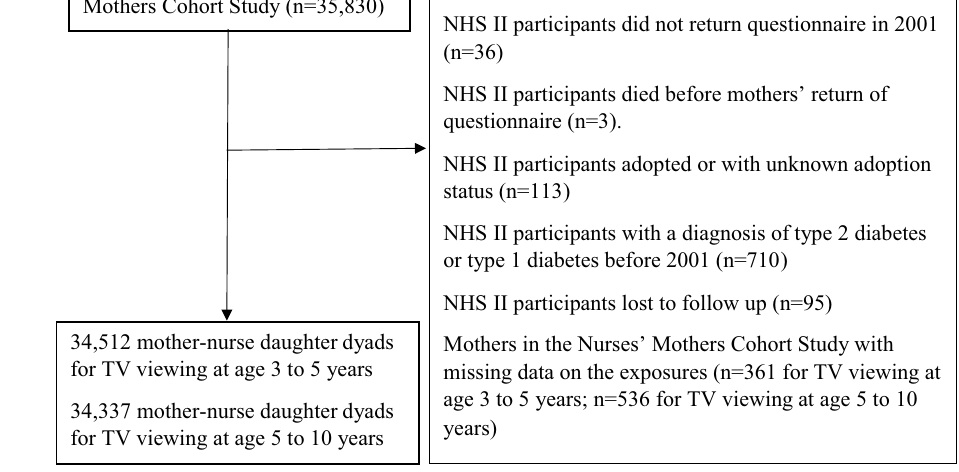
Figure 1. Flow chart of study selection